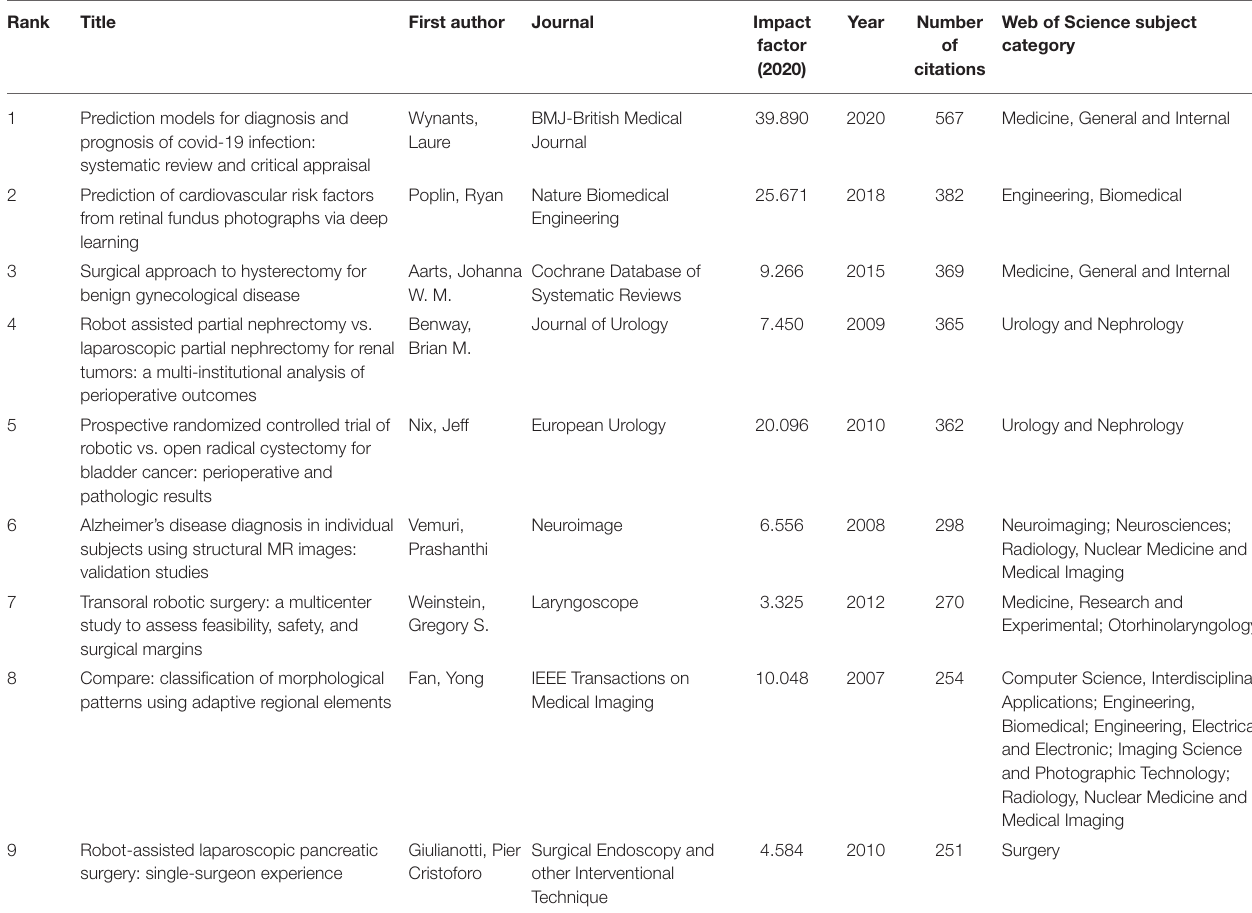
TABLE 6 | The papers with the most frequent citations of gender-related medical artificial